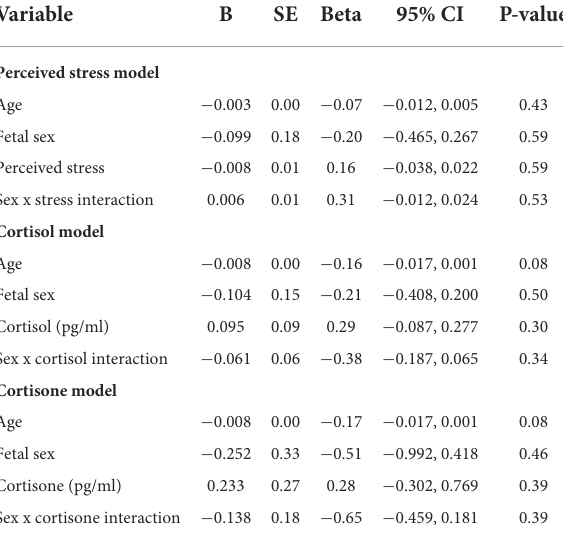
TABLE 4 Linear regression models for effects of maternal perceived stress, cortisol, cortisone, and the moderating effect of fetal sex on gestational length.